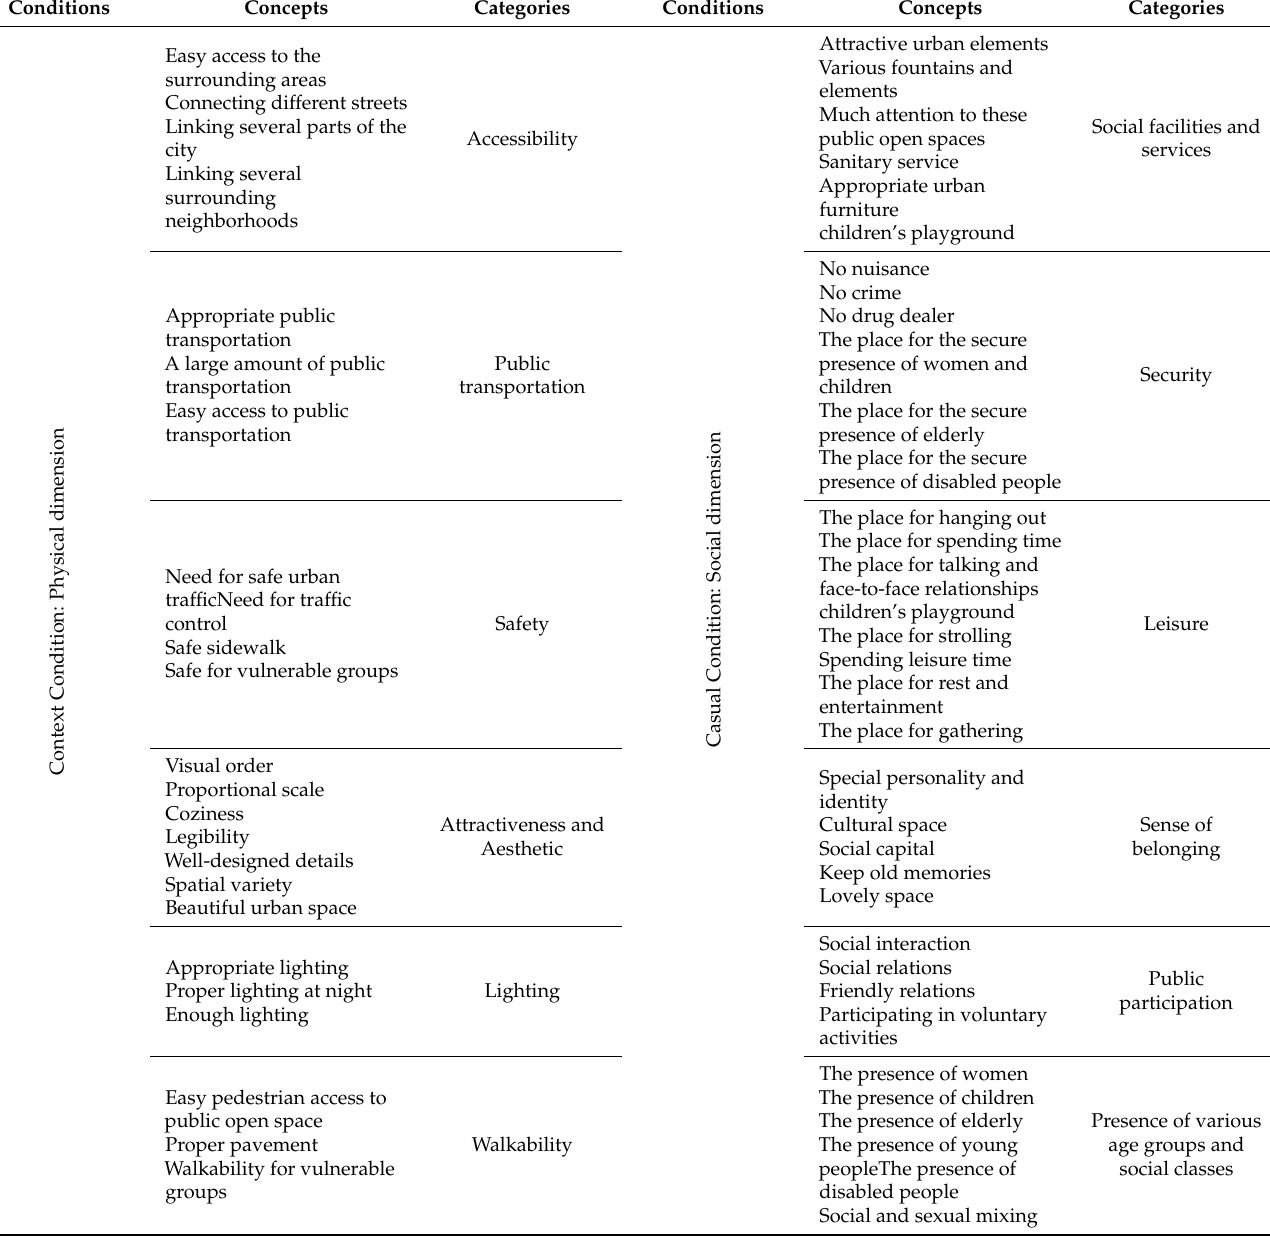
Table 4. The concepts, categories, and dimensions of environmental quality of public open spaces related to urban mental well-being by